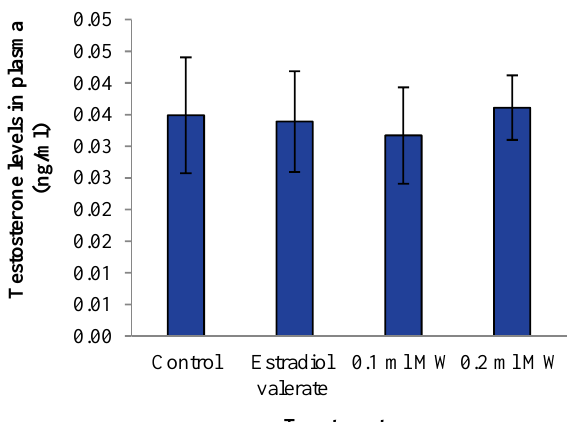
Figure 2. Plasma testosterone levels in immature common carp treated with estradiol valerate and different concentrations of municipal wastewater for 21 days (mean ± SD) (n = 9) Asterisk (*) indicates that the di ff erence between the experimental and control groups was significant at P <